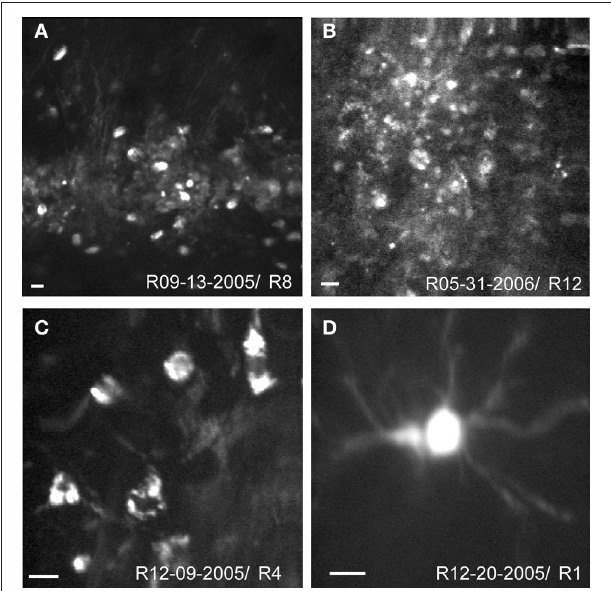
FIGURE 2 | In vivo structural two-photon scanning of Sindbis Flare transfected neurons in rat visual cortex. (A,B) Labeled cell bodies and neuropil at low magnification. (C,D) High magnification images of soma and dendrites. Scale bars, 10 μ m. Depth of scanning for each example was